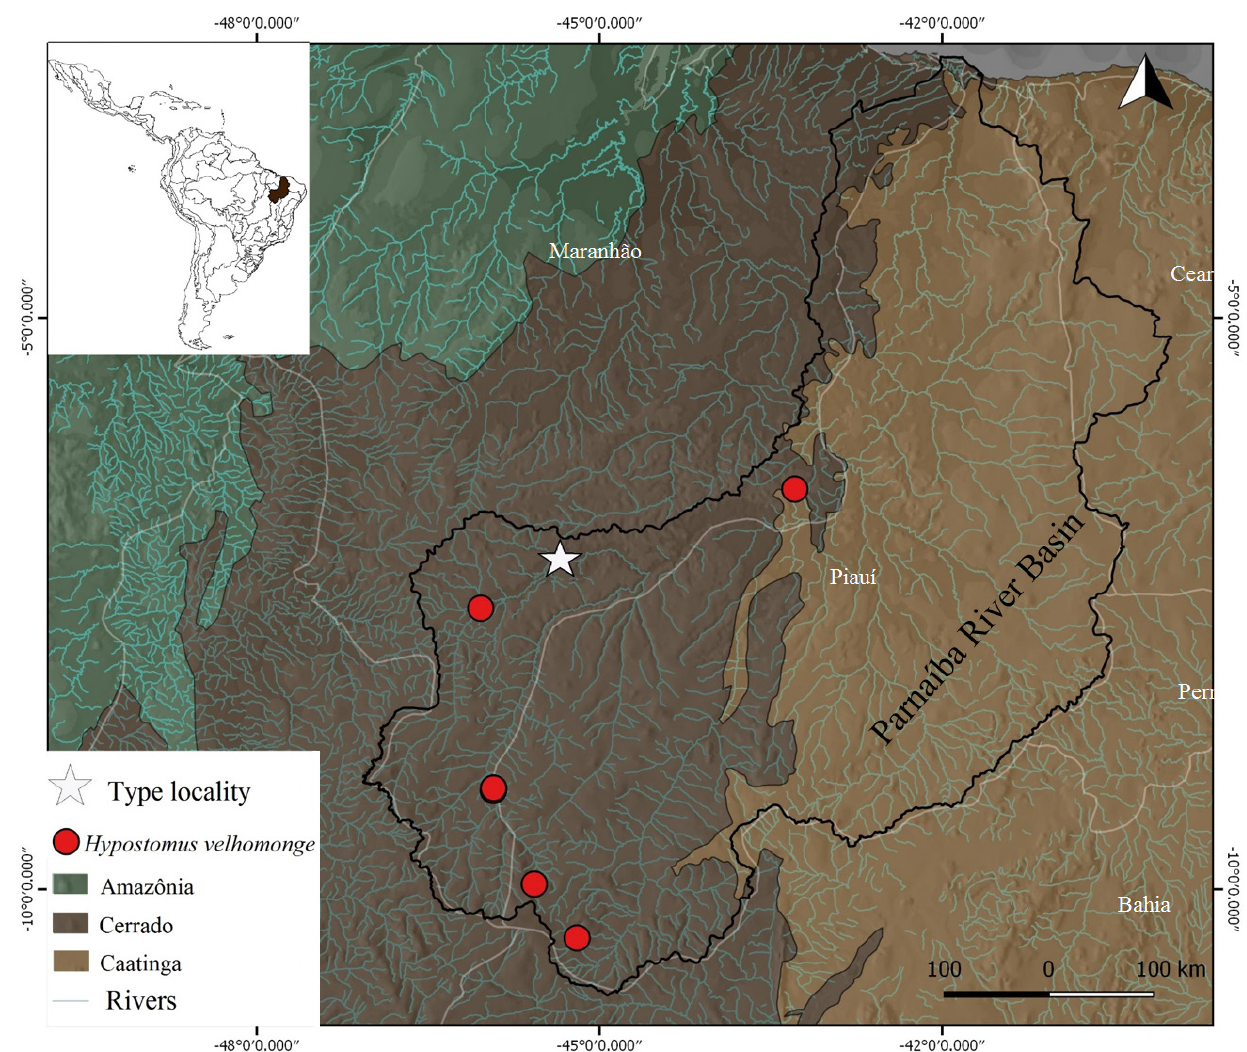
FIGURE 6 | Geographic distribution of Hypostomus velhomonge in the Parnaíba River basin, Northeast